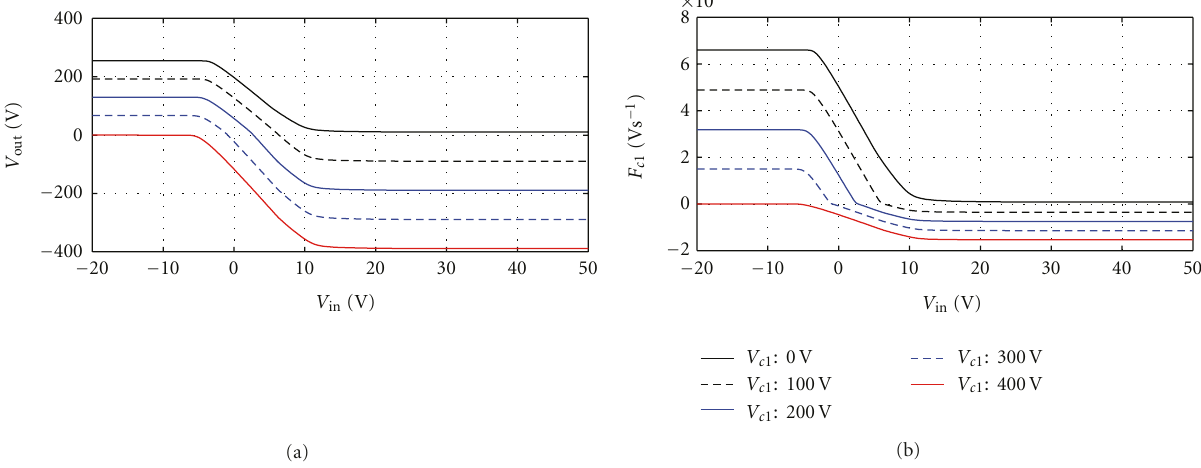
Figure 6: Approximating functions for the simulation of the system (12)—output function (a) and capacitor C 2 update function (b).